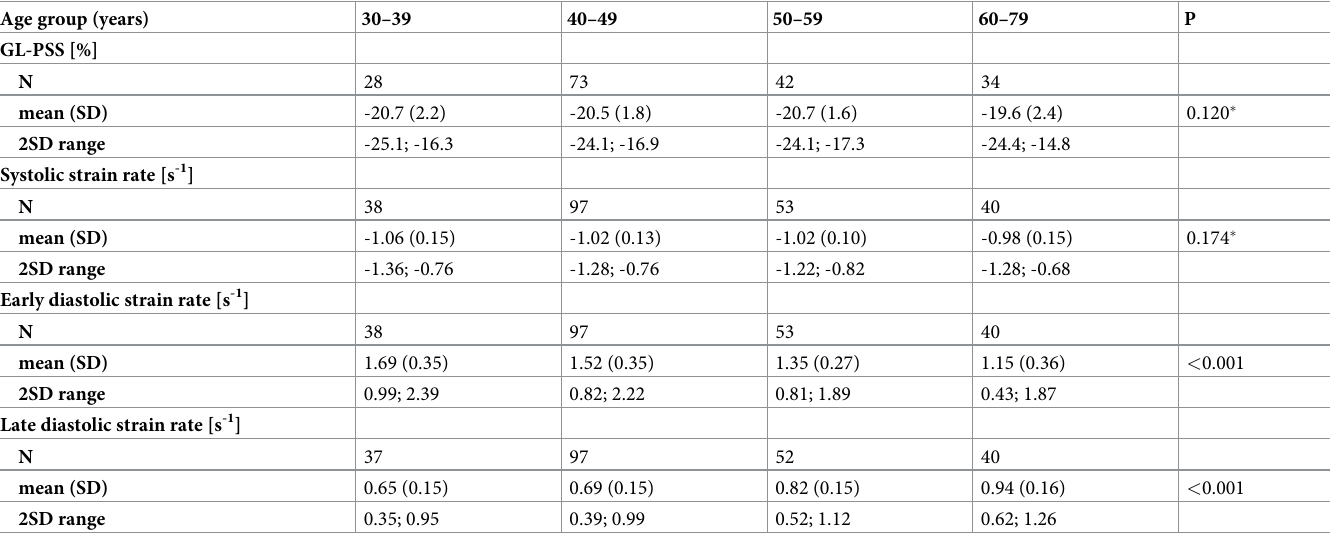
Table 3. Speckle tracking derived markers of left ventricular myocardial deformation in female participants by age